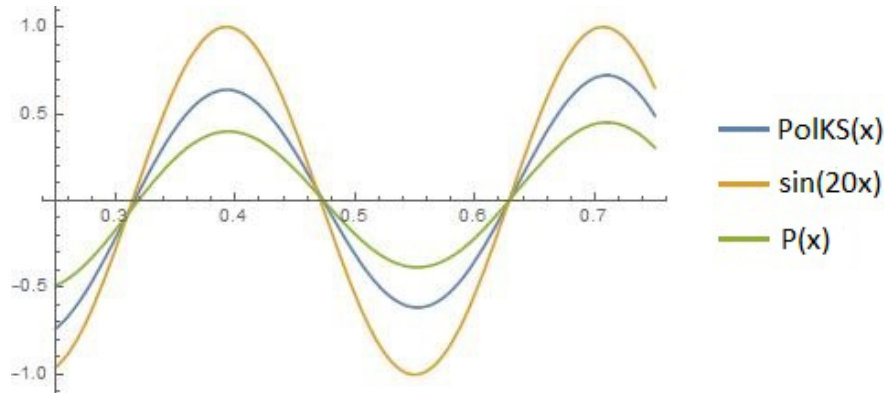
Figure 5. f ( x ) = sin ( 20 x ) , α = 10, β = 20, m = 50 iterations.